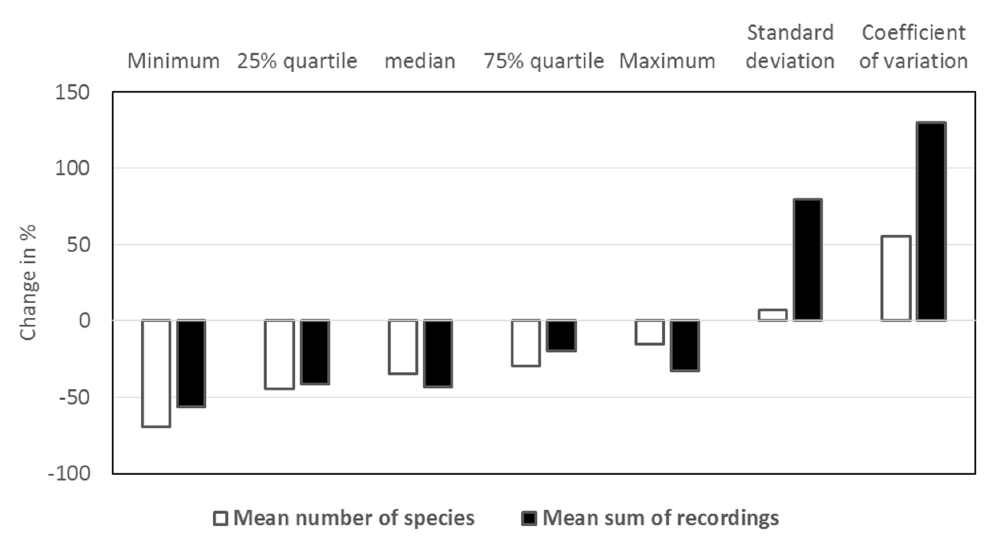
Figure 4. Change of distribution parameters of the mean species numbers and sum of individual bird recording between the observation campaigns (1999–2002; 2013–2015) at the sample plots.